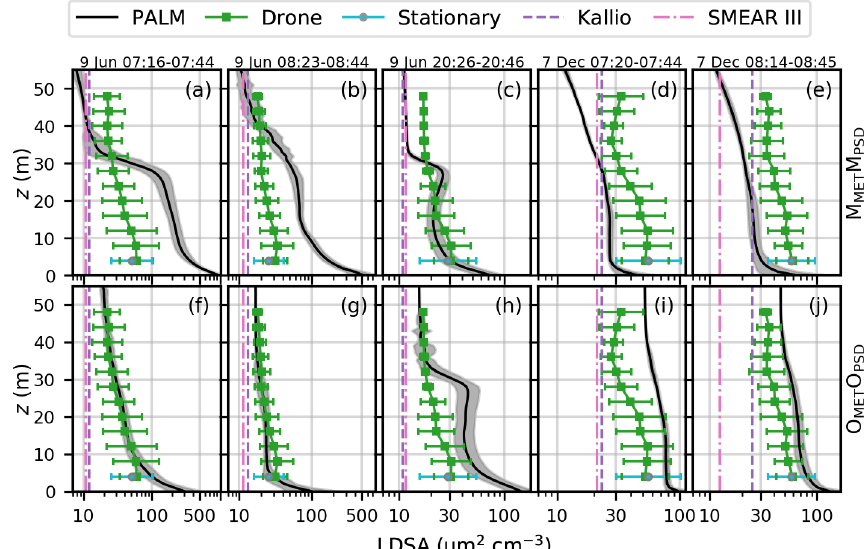
Figure 6. Measured (marker with error bar) and modelled (black line and grey-shaded area) LDSA of aerosol particles at the supersite for the summer morning ( a, f for the first and b, g for the second hour), summer evening (c, h) and winter morning ( d, i for the first and e, j for the second hour). The first row shows M MET M PSD and the second O MET O PSD . The figure shows the geometric mean (measured: marker; modelled: solid line) and geometric standard deviation (measured: error bar; modelled: shaded area). Dashed lines show the geometric mean at the urban background monitoring sites in Kallio and SMEAR III.